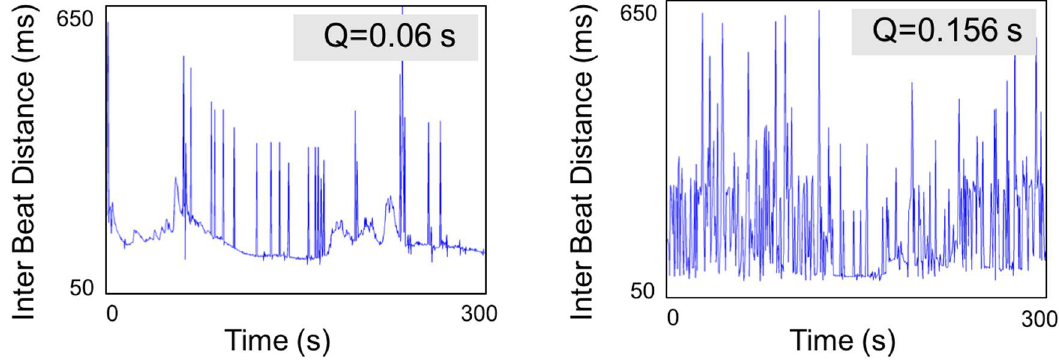
Figure 6. Two examples of quality index computation in FECG signals. Left panel show a reliable lead, and right panel refers to a lead in which the FQRS and F interbeat estimation were unreliable.